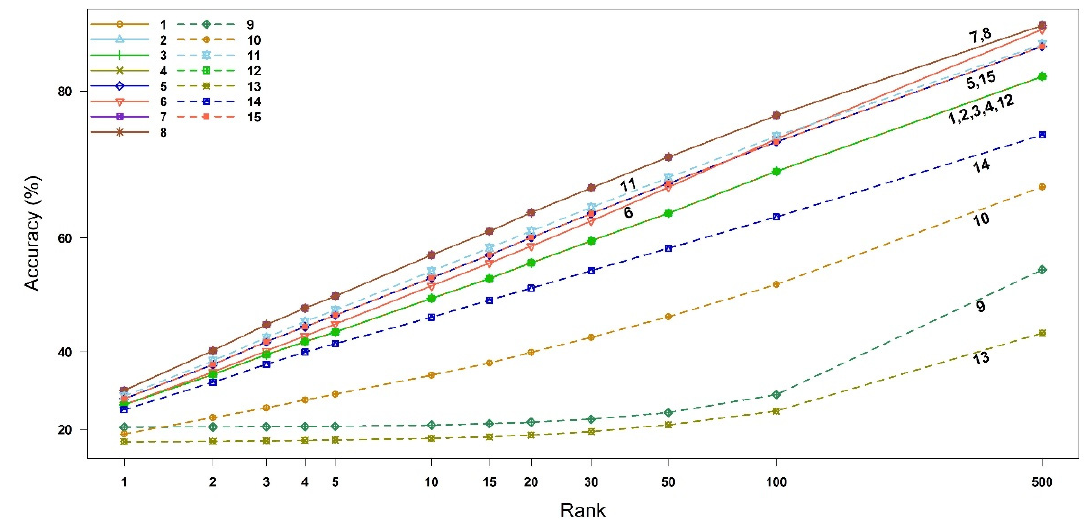
Figure 2. Accuracy of all similarity measures for EI mass spectra-based compound identification by rank. The x -axis represents the ranks and the y -axis the identification accuracy. The numbers in legend and plot are the indices of binary similarity measures corresponding to Table 4 of Section 4.